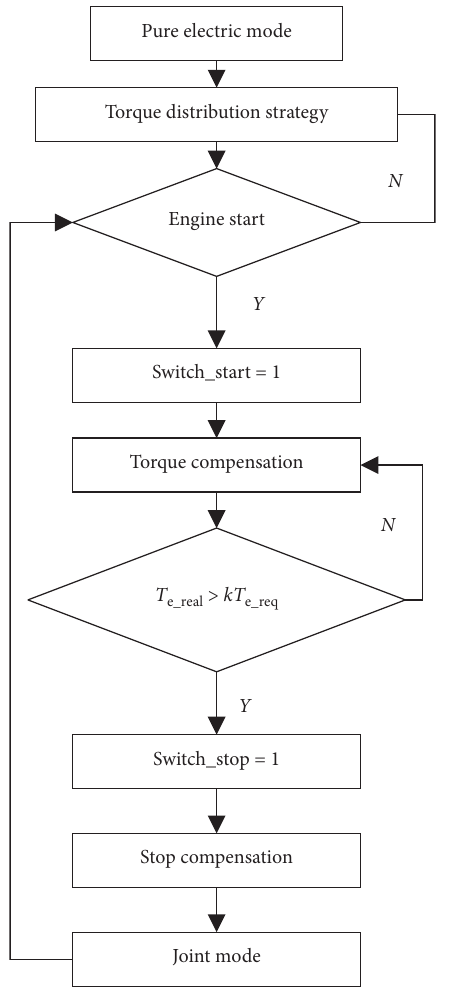
Figure 9: Flow chart of dynamic coordinated control.